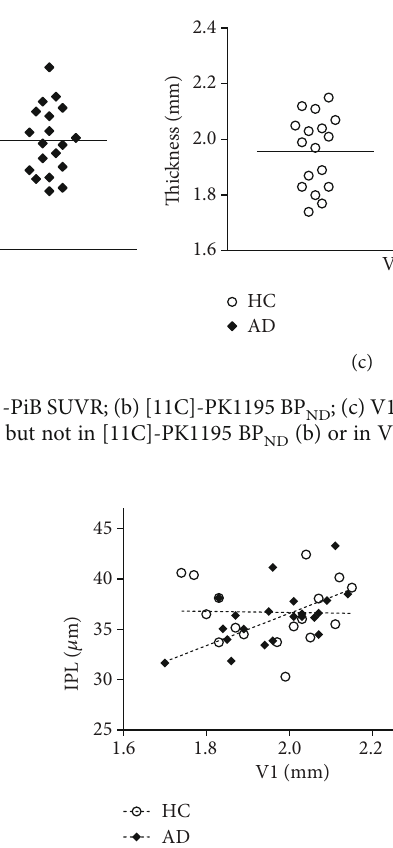
Figure 4: Scatterplot graph for the V1 thickness and IPL thickness to HC and